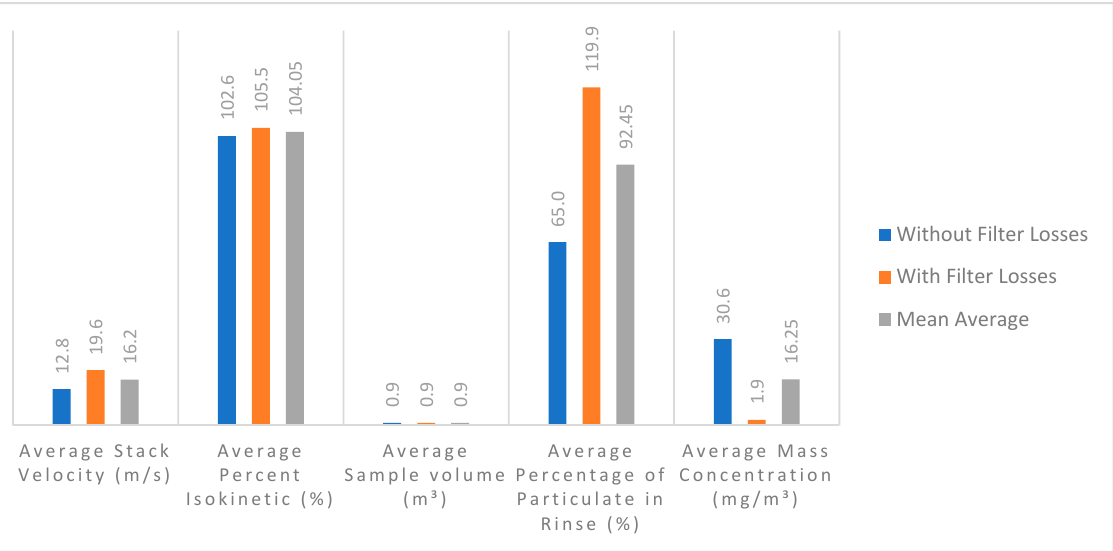
Figure 6. Comparison of an average of testing parameters for samples with and without filter